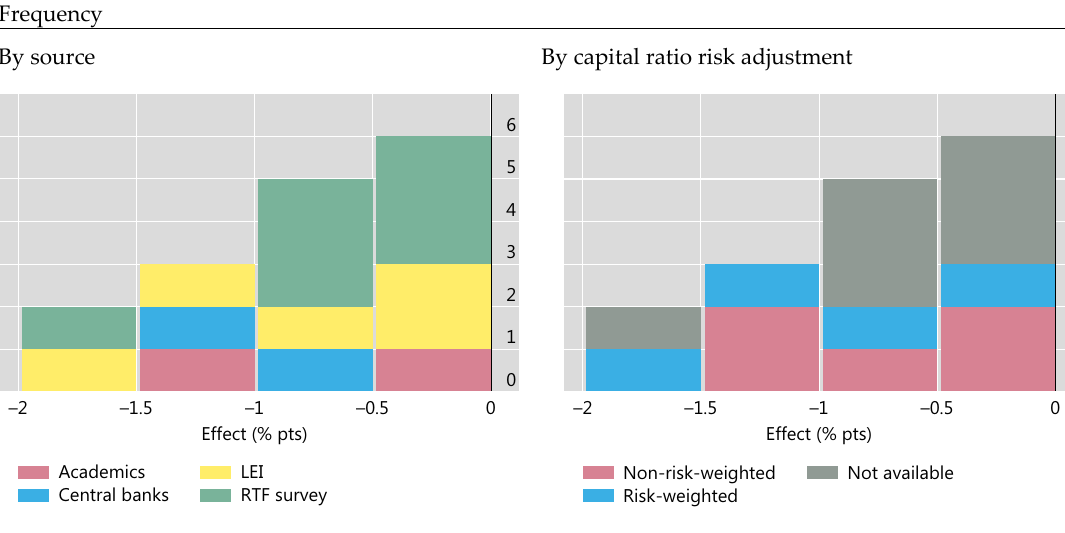
Figure 2. Effect of a one percentage point higher capital ratio on crisis probability frequency. Based on seven RTF survey responses and nine estimates from seven studies (see references Almenberg et al. (2017), Barth and Miller (2018), BCBS (2010), Brooke et al. (2015), Firestone et al. (2017), Jorda et al. (2017), Mikkelsen and Pedersen (2017)). In some cases, whether or not the capital ratio is risk-weighted is not specified (“Not available”). Source: Financial Regulation Assessment: Meta Exercise, stats.bis.org/frame. The right panel shows the breakdown of the e ff ects by whether or not the capital ratio is risk-based. A higher risk-based capital ratio appears to have a larger negative e ff ect on the crisis probability than a higher leverage